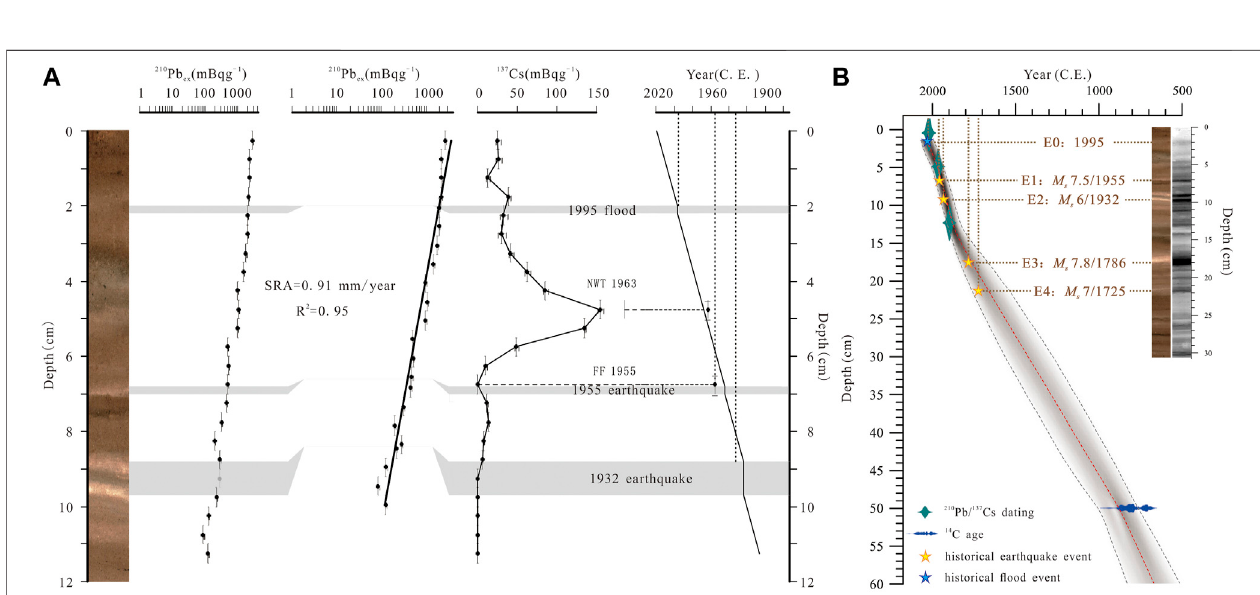
FIGURE 6 | Chronology model for cores MGC21A and MGC-2. 210 Pb/ 137 Cs dating results of the core MGC21A (A) . Age-depth model derived from 210 Pb/ 137 Cs dating of the core MGC21A and AMS 14 C dating of the core MGC-2 (B) . E0- fl ood event; E1, E2, E3, and E4- earthquake events.